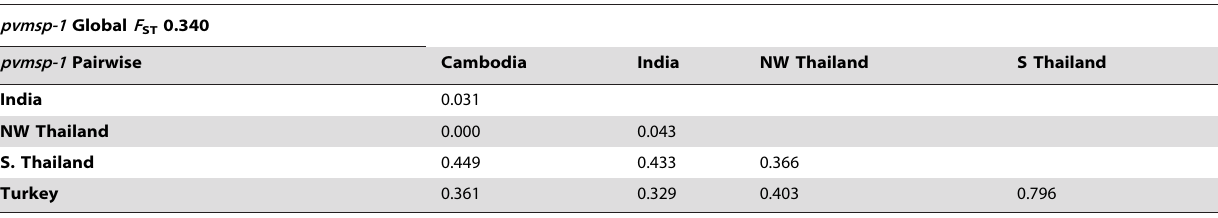
Table 3. Interpopulation F -statistics for pvmsp-1